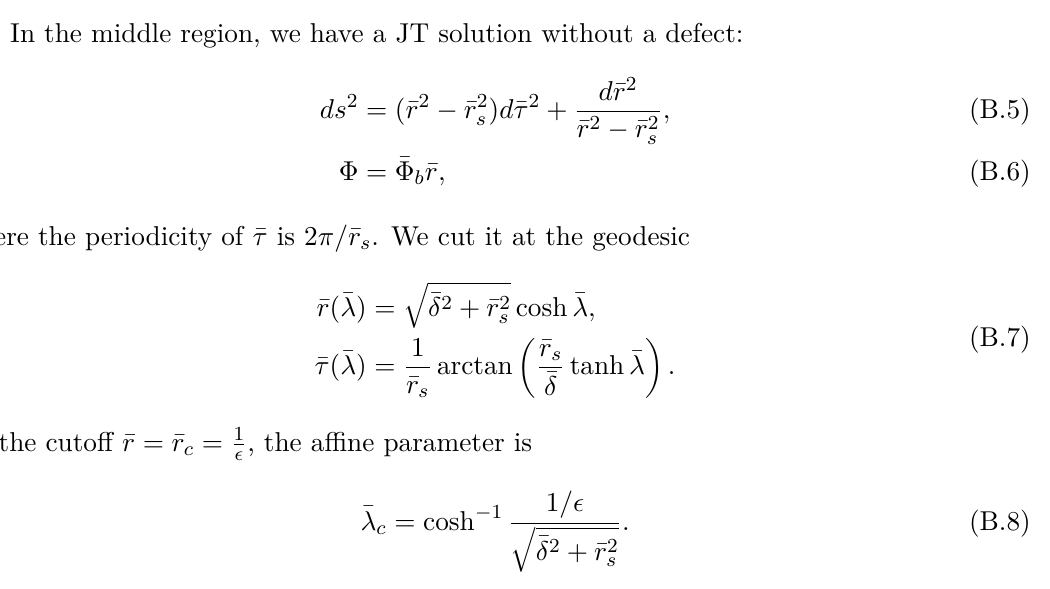
Figure 7 . Left: we take solutions corresponding to a conical defect of opening angle 2 πm and cut pieces of it, denoted I and III, slightly greater than half so as to avoid the defect. We then patch it onto a portion of the smooth AdS 2 solution, labelled II, by imposing matching conditions on the geodesic and at the asymptotic boundary. This leads to a regularized split solution which can be analytically continued to a Lorentzian spacetime. In the limit δ → 0 , we obtain the same solution that we expect from initial data